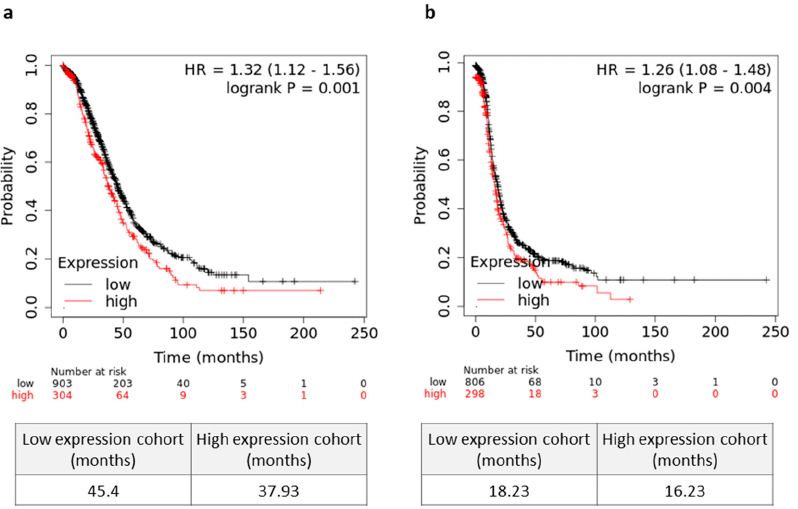
Figure 5. Prognostic relevance mortalin in serous ovarian cancer (OC) patients. ( a ) The overall survival (OS) ( a ) and progression free survival (PFS) ( b ) values of the OC patients with high/low levels of HSPA9 are shown as Kaplan–Meier curves. Microarray datasets (online KM plotter database, JetSet best probe set) were used for mortalin gene expression.